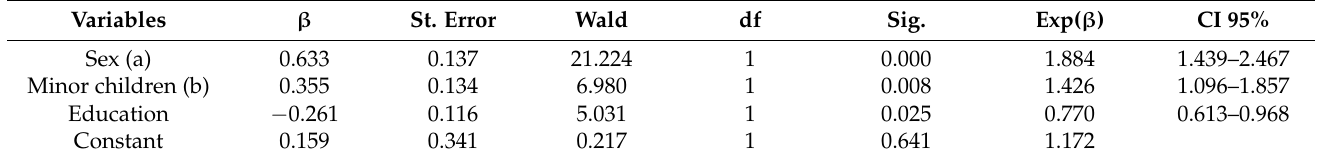
Figure 1. ( a ) Perceived threat by gender. ( b ) Perceived threat by whether there were minor children in their care. Table 3. Results derived from the logistic regression for probability of perceived